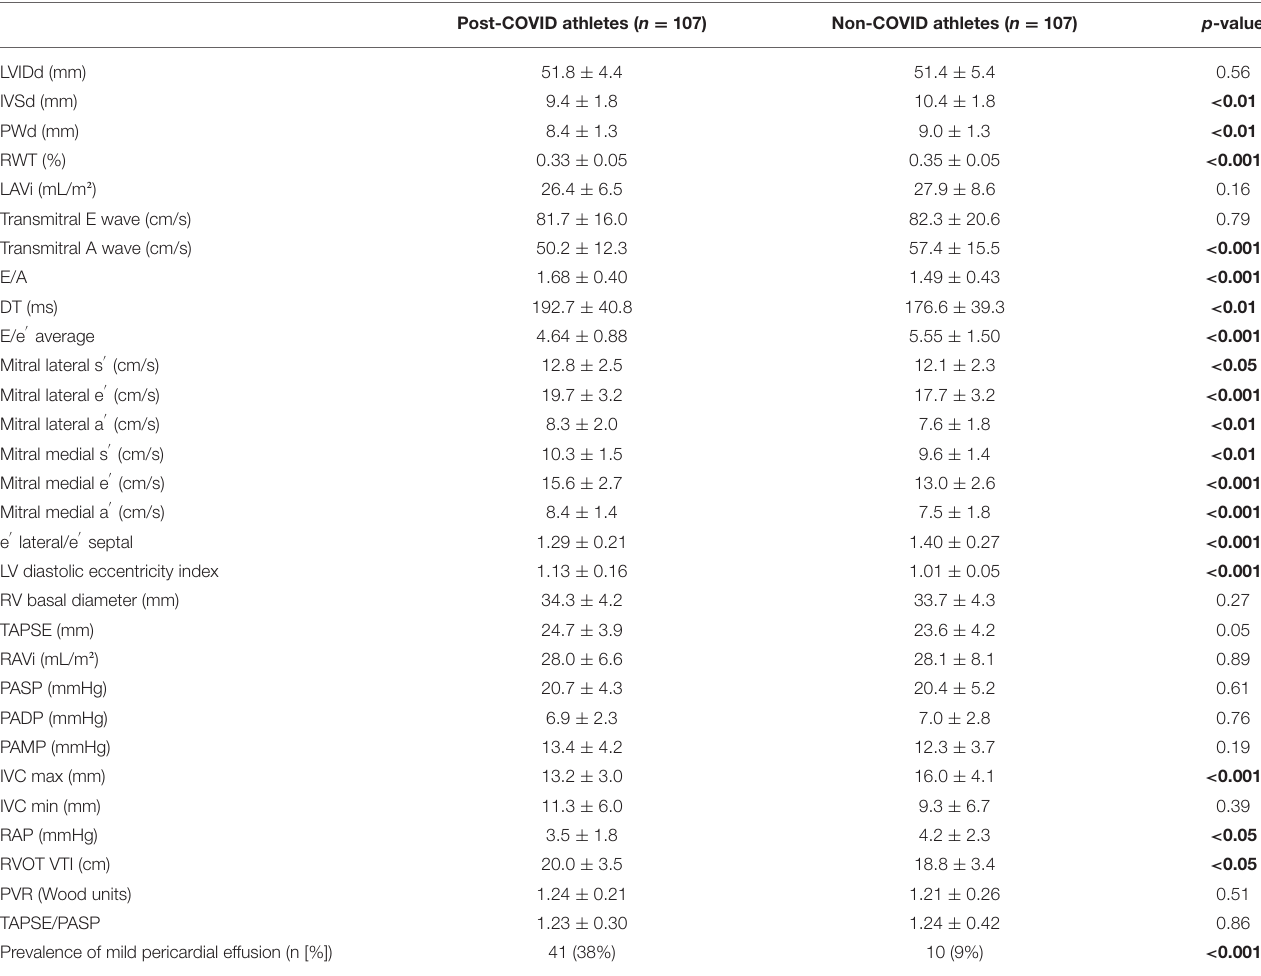
TABLE 2 | Conventional echocardiographic left- and right heart parameters in the post-COVID and the non-COVID athlete groups.